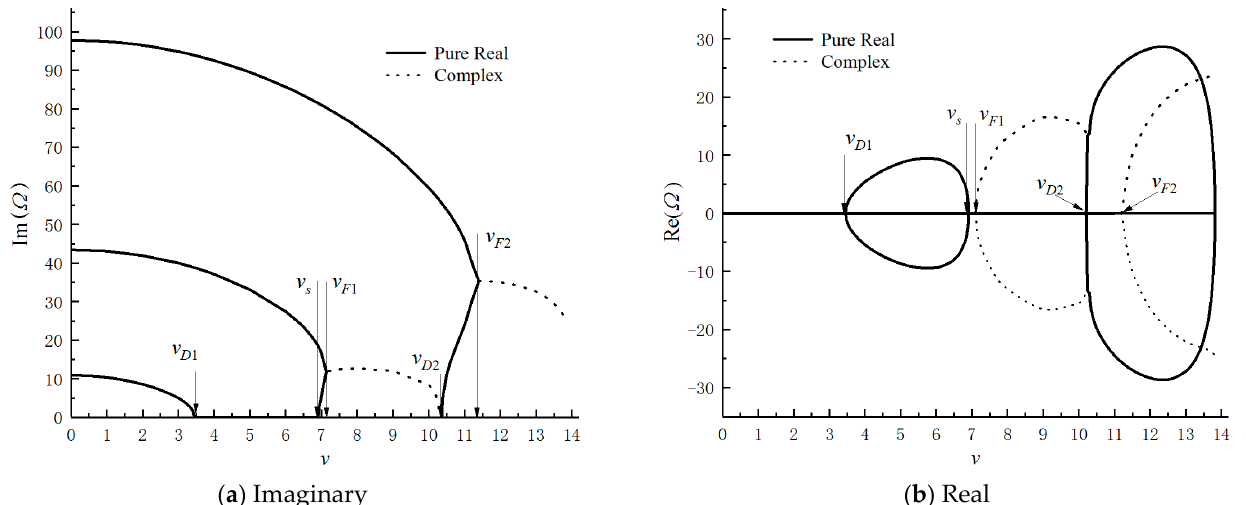
Figure 3. Curve of the imaginary part of the first three complex frequencies of SS beam changing with axial velocity.